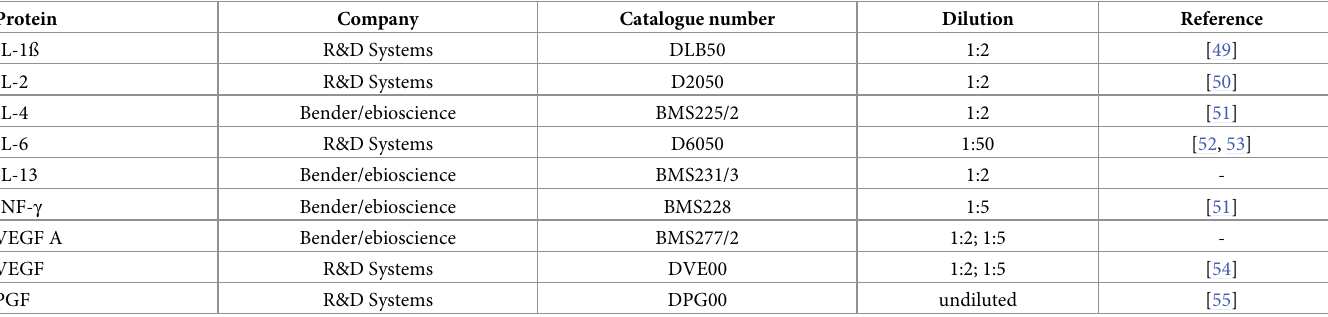
Table 2. Applied ELISA assays including company, catalogue number, used dilution and references.